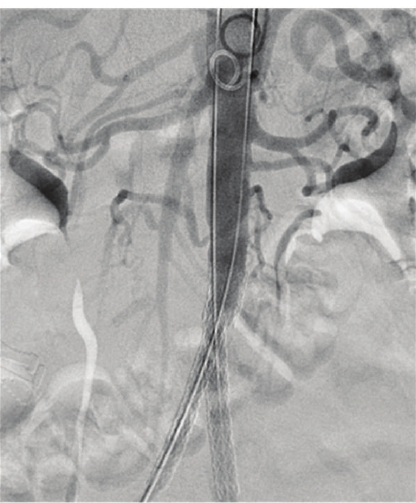
Figure 7: Reconstruction of the aortoiliac occlusion with an aortic stent and bilateral kissing iliac